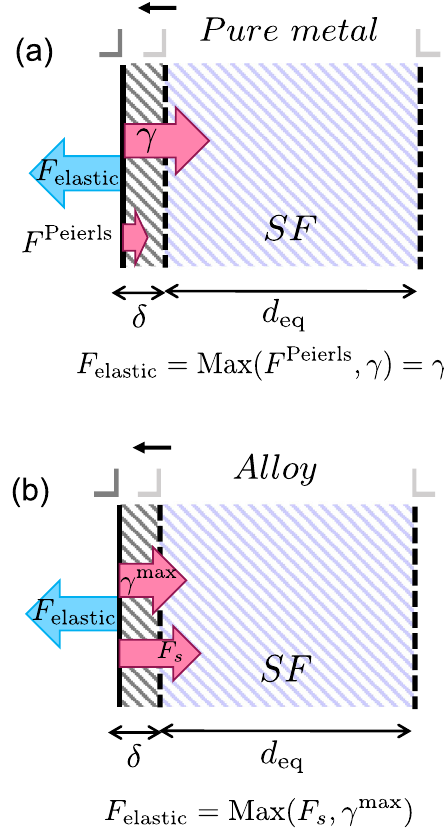
Fig. 9 Schematic demonstration of the various forces, acting on a Shockley partial dislocation during dissociation. The process is shown in ( a ) a pure metal and ( b ) an alloy. The elastic interaction F elastic pushes the left partial dislocation to the left, provided it can overcome the maximum resisting force to moving the dislocation incrementally by amount δ . The Peierls barrier in elemental fcc metals is negligible hence the F elastic should counteract γ . In an alloy, SFE is a distribution with its upper bound represented by γ max . Both γ max and the solute/dislocation interaction F s resist the motion of the Shockley partial. In order to move the dislocation by an amount δ beyond the equilibrium position, F elastic needs to counteract the maximum resistance given by the maximum of γ max and F s